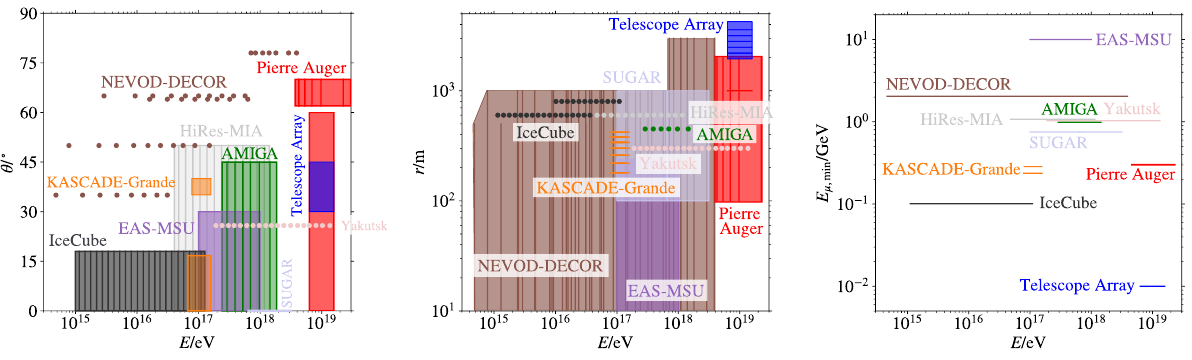
Figure 2. Air shower experiments have measured the muon density at ground under various conditions, which are shown here. Points and lines indicate a measurement in a narrow bin of the parameter, while boxes indicate integration over a parameter range. Left: Zenith angle of air showers versus shower energy. Middle: Lateral distance of the muon density measurement versus shower energy. Right: Energy threshold for the muons that are counted in the experiment. Some experiments measure muons below a shielding, which increases the muon energy